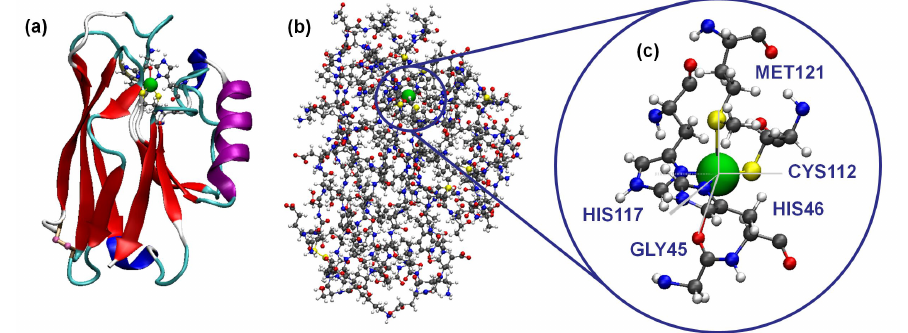
Figure 2. Structure of the blue copper azurin of Pseudomonas aeruginosa used in this work. ( a ) Ribbon representation of the tertiary structure of the protein, showing the amino acids of the first coordination sphere of the Cu center. ( b ) Ball-and-stick model of the whole protein. ( c ) Detailed view of the Cu complex of the protein displaying the five residues of the first coordination sphere with its typical geometry of distorted trigonal